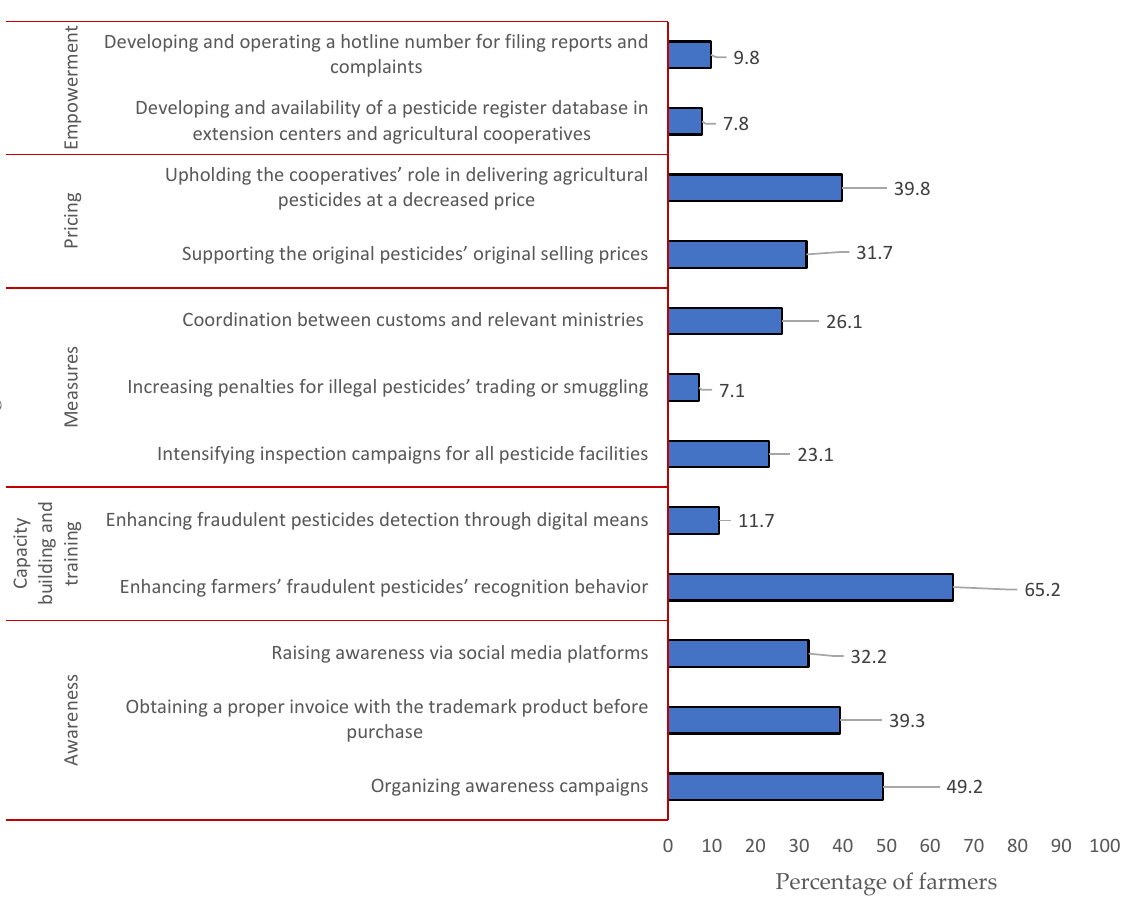
Figure 1. Strategies for combatting fraudulent pesticides from the farmers’ point of view.